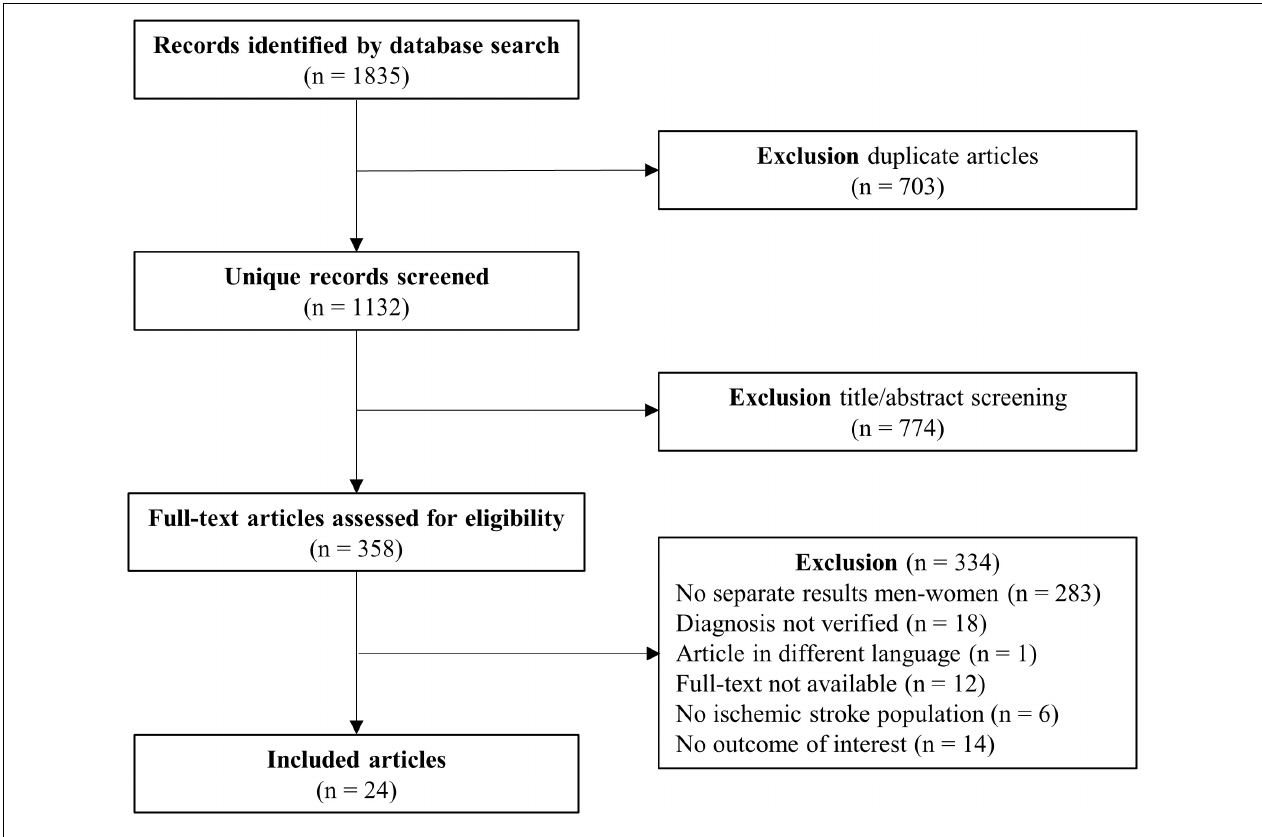
FIGURE 1 | PRISMA flow chart study selection sex differences in ischemic stroke.